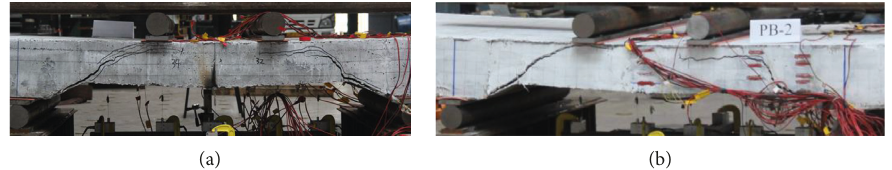
Figure 13: Failure modes of (a) P1 and (b) P2